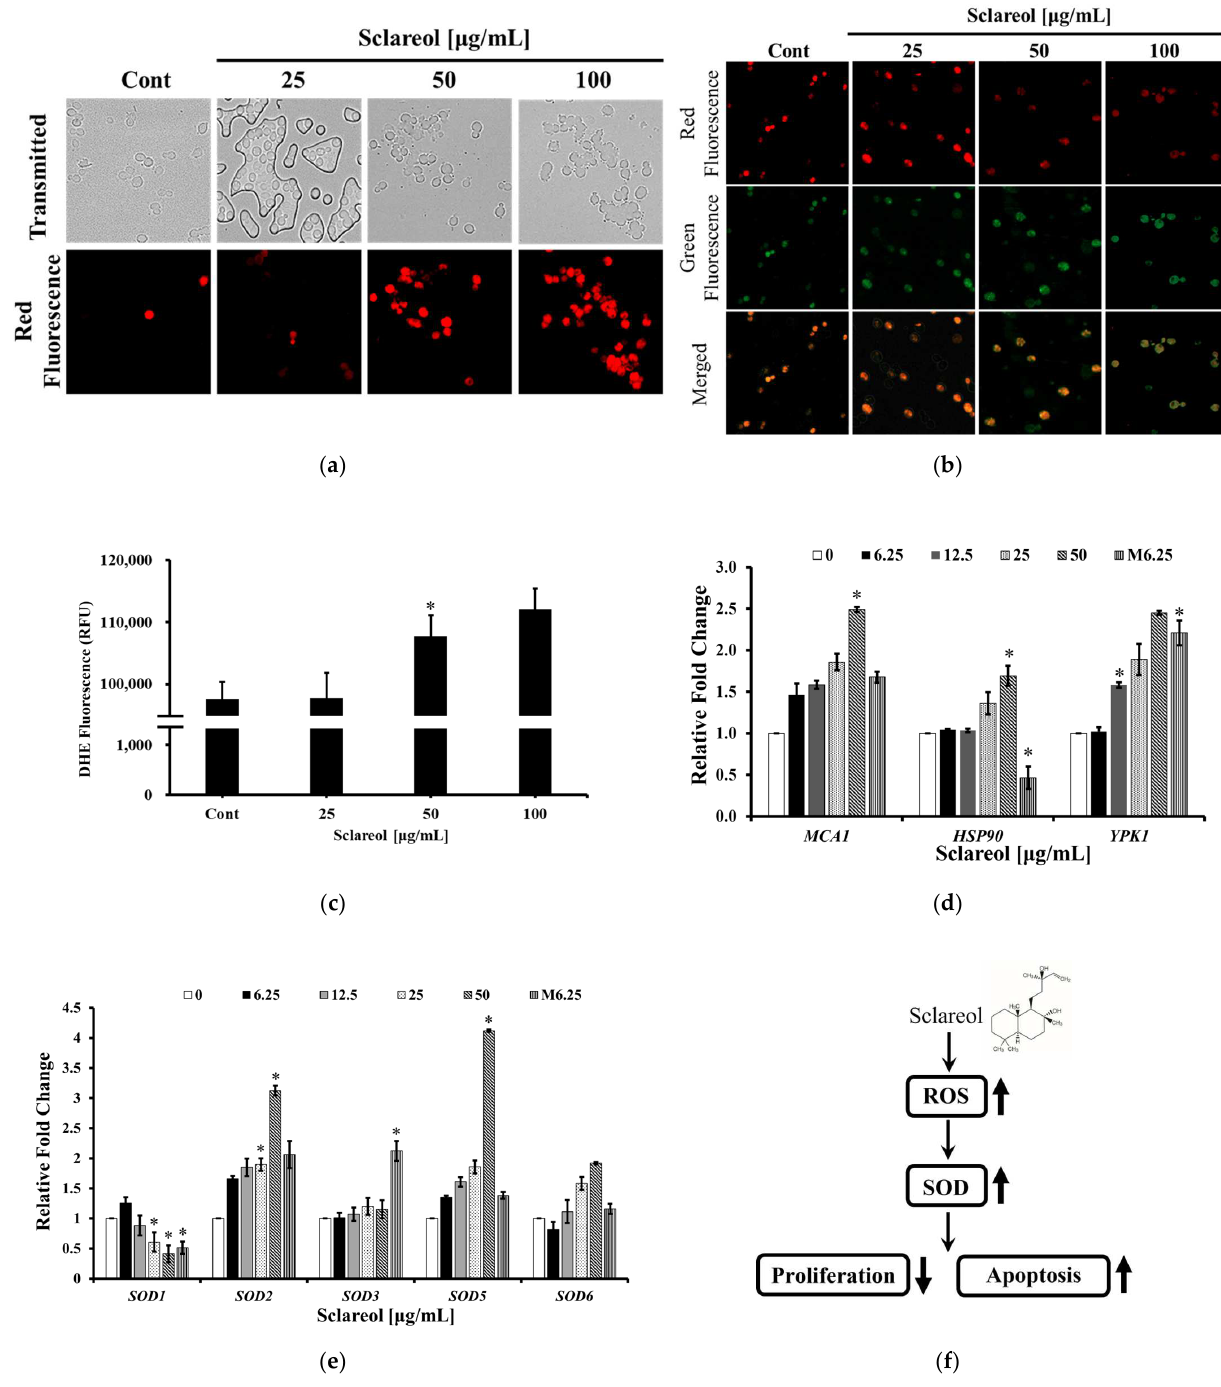
Figure 3. Sclareol-induced apoptosis-like cell death of C. albicans : ( a ) Propidium iodide (PI) staining showed fungal apoptosis-like cell death, a response caused by sclareol. Before fluorescent staining, C. albicans was cultured in YPD, and then treated with indicated concentration of sclareol for 2 h at 30 ◦ C. ( b ) Sclareol induced depolarization of mitochondrial membrane potential in C. albicans . Visualization by fluorescent microscopy of C. albicans stained with JC-1. C. albicans was cultured in YPD, and then treated with indicated concentrations of sclareol for 2 h at 30 ◦ C. Cells were washed with PBS and stained with 0.5 µ M of JC-1 for 15 min. ( c ) Sclareol-induced apoptosis in C. albicans by increasing ROS levels. The graph shows intracellular ROS levels in 25–100 µ g/mL sclareol-treated cells at 2 h. Cells were stained with dihydroethidium and analyzed by reading excitation and emission